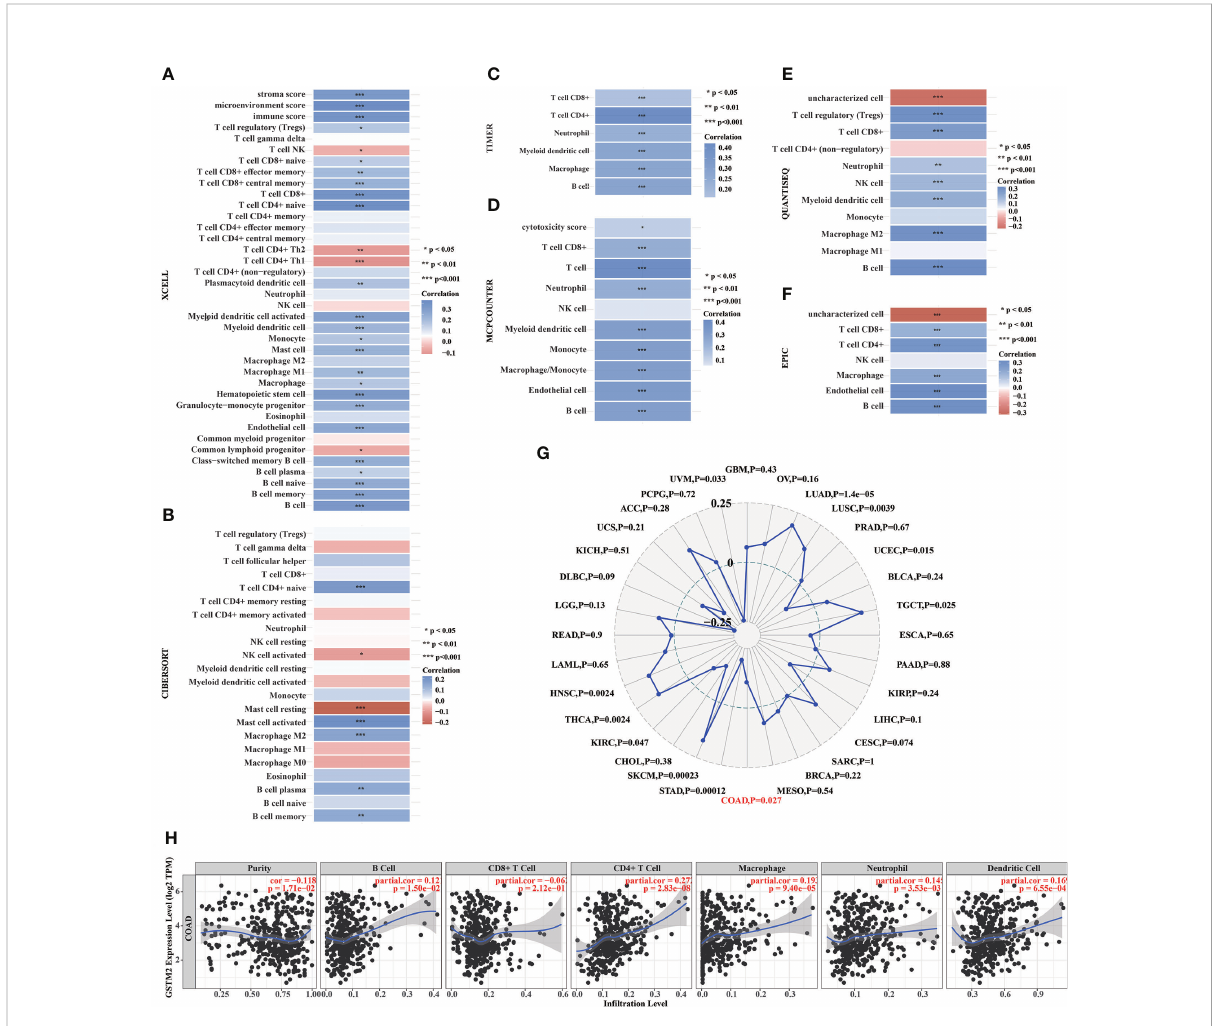
FIGURE 6 The GSTM2 Expression in Colon Cancer was Potentially Related to Immune In fi ltration. (A – F) The correlation between the GSTM2 expression and in fi ltration ratios of immune cells in colon cancer as analyzed separately using the XCELL, CIBERSORT, TIMER, MCPCOUNTER, QUANTISEQ, and EPIC algorithms. (G) The correlation between GSTM2 expression and MSI in various tumors. (H) The correlations between GSTM2 expression and the in fi ltration levels of six classic types of immune cells in colon cancer. *p < 0.05, **p < 0.01, ***p <